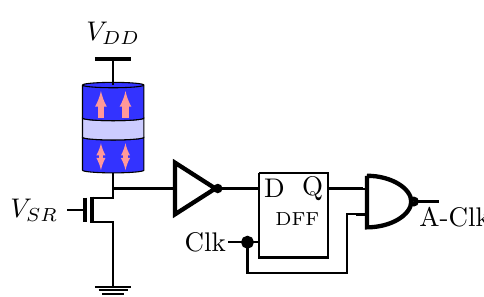
Figure 17. Adaptive Quantization Rate (AQR) generator proposed in Reference [72].